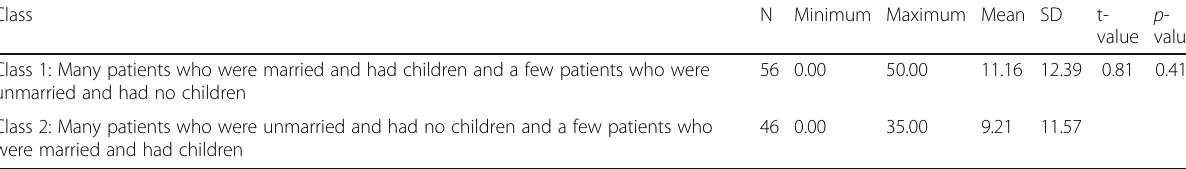
Table 4 Descriptive statistics of the Japanese DRS of 2 classes and the result of the t-test Class N Minimum Maximum Mean SD t-